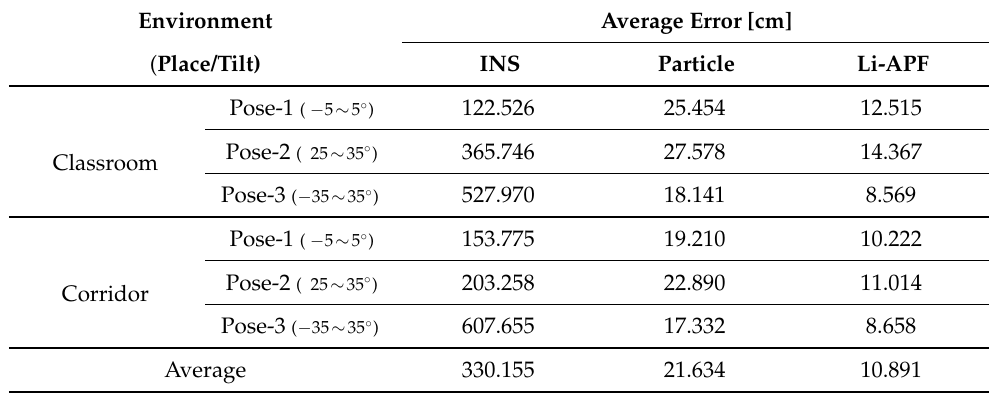
Table 2. The results of the tracking experiment in various